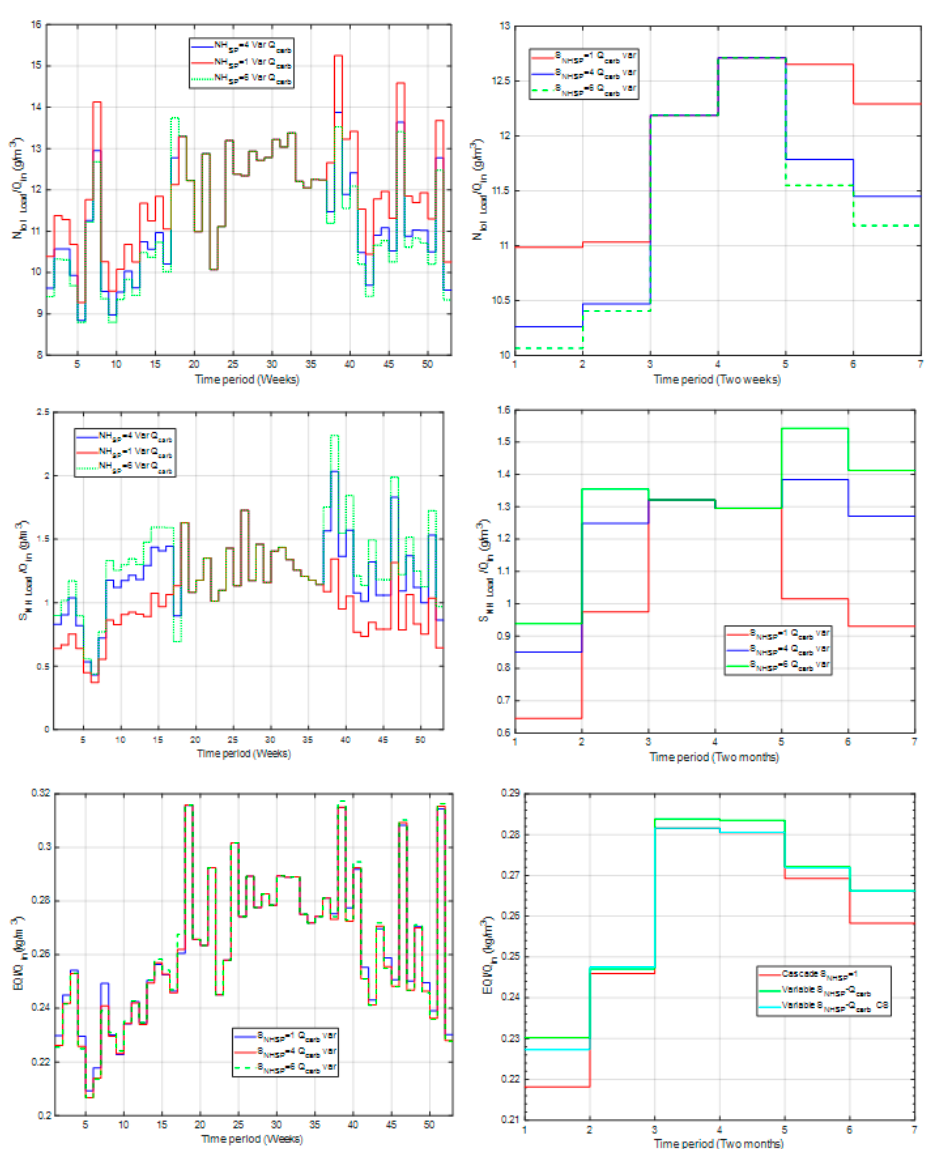
Figure A3. Weekly and bimonthly profile for emissions to water indicators N tot Load /Q in (g/m 3 ), S NH Load /Q in (g/m 3 ) and EQI/Q in (kg/m 3 ) with alternative control actions. Table A1. Annual values of environmental indicators and operating costs of BSM2 plant with respect to the volume of treated wastewater with alternative strategies.